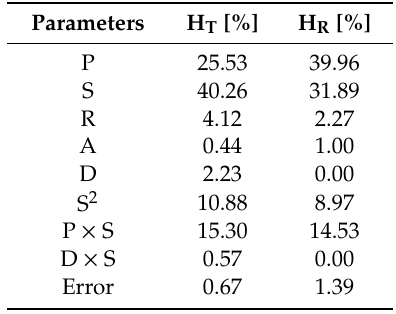
Table 7. Parameters contributions as a percentage [%] in the case depth of